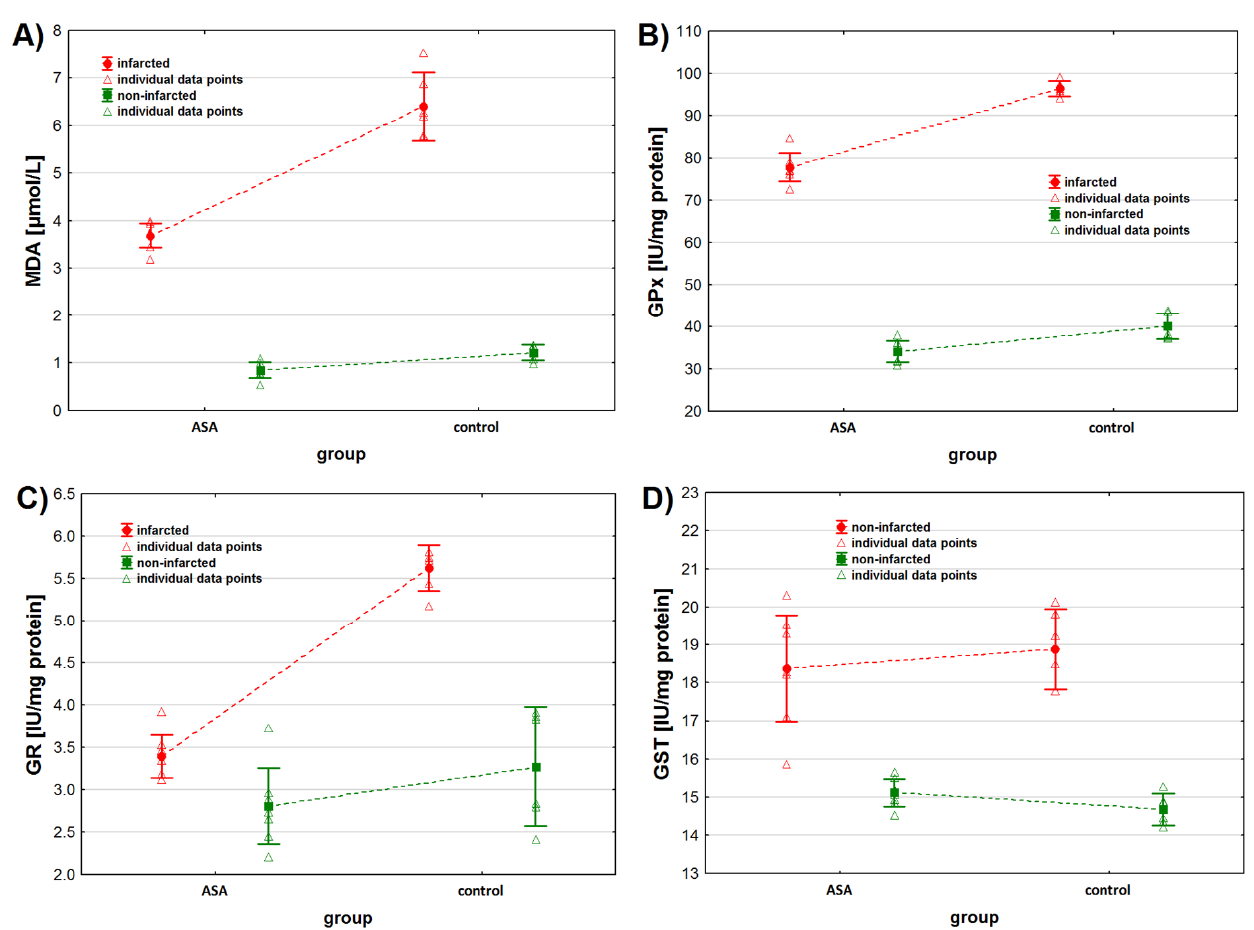
Figure 2. Oxidative stress markers levels in infarcted and the non-infarcted tissues collected from the left ventricle of the heart of pigs ( n = 13) subjected to a myocardial ischemia-reperfusion protocol assessing the effectiveness of intracoronary administered acetylsalicylic acid (ASA): ( A ) malondialdehyde (MDA) concentration [µmol/L], ( B ) glutathione peroxidase (GPx) activity [IU/mg protein], ( C ) glutathione reductase (GR) activity [IU/mg protein] and ( D ) glutathione S-transferase (GST) activity [IU/mg protein]. The results are presented as mean ± 95% confidence interval and triangular markers represent the raw data. For the reader’s convenience, the points are connected with dashed lines.